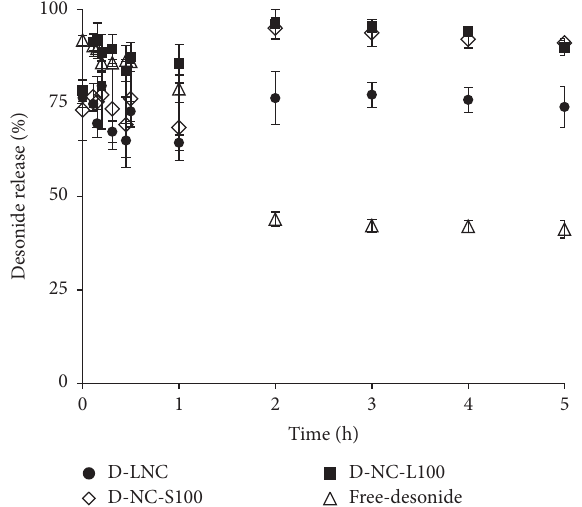
Figure 5: Release profile of D-NC-S100, D-NC-L100, D-LNC, and free-desonide using dissolution method. Statistical significance among D-NC-L100 and free-desonide (Tukey, 𝑝 < 0.05